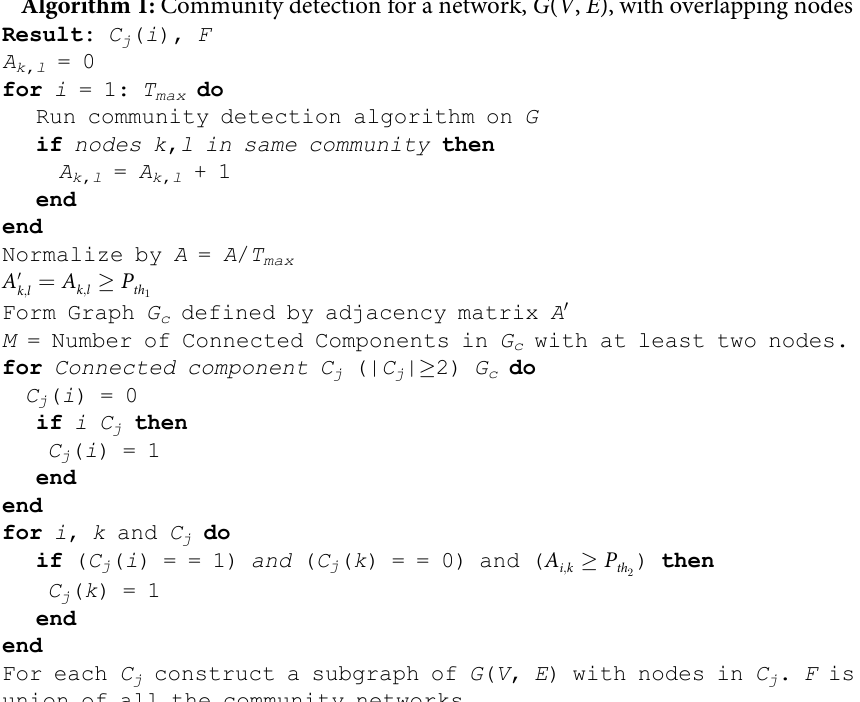
Algorithm 1: Community detection for a network, G ( V , E ), with overlapping